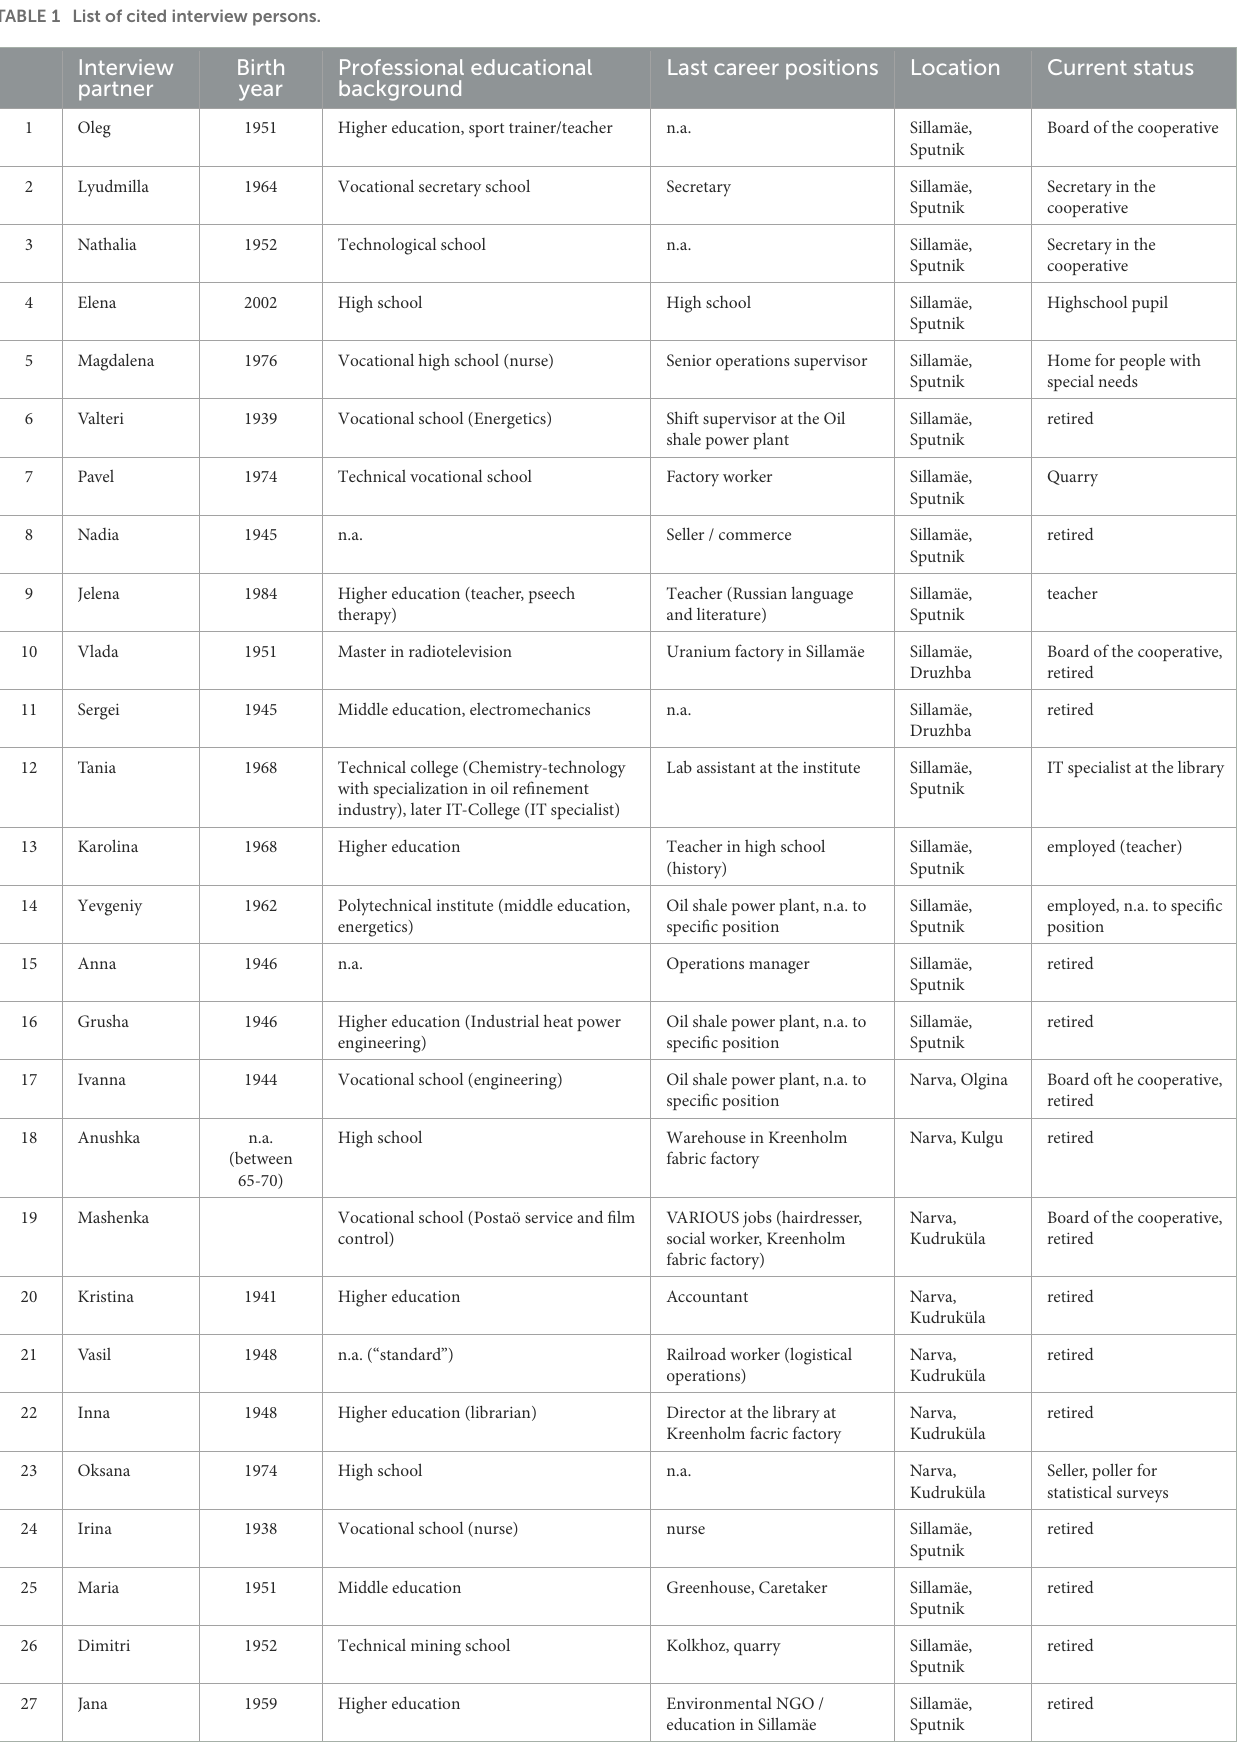
TABLE 1 List of cited interview